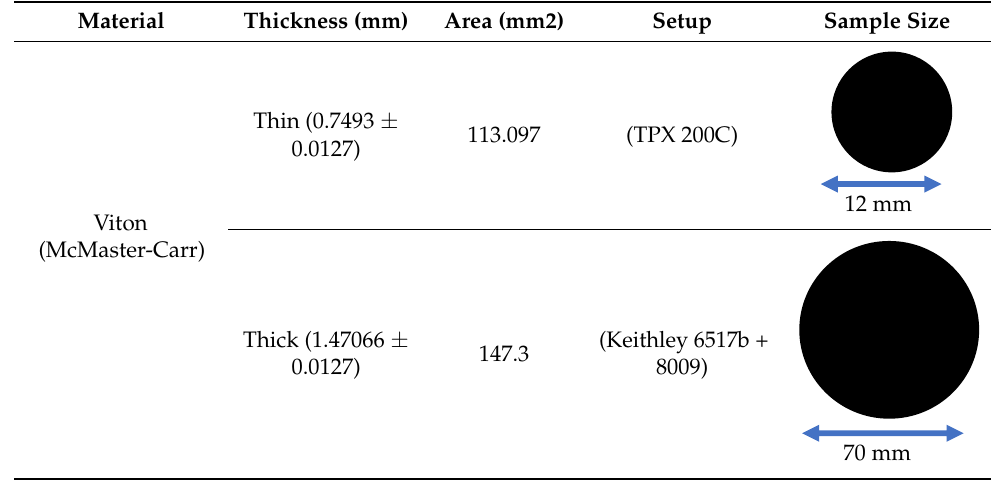
Table 1. Parameters of the polymer (Viton) sample used in the experiment.